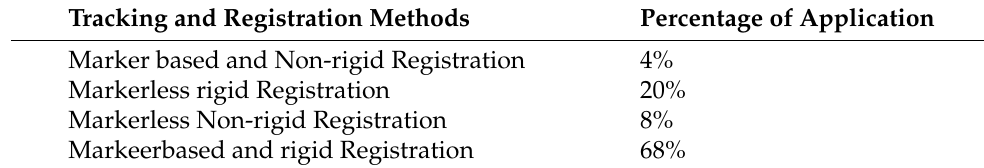
Table 4. Augmented Reality tracking and registration